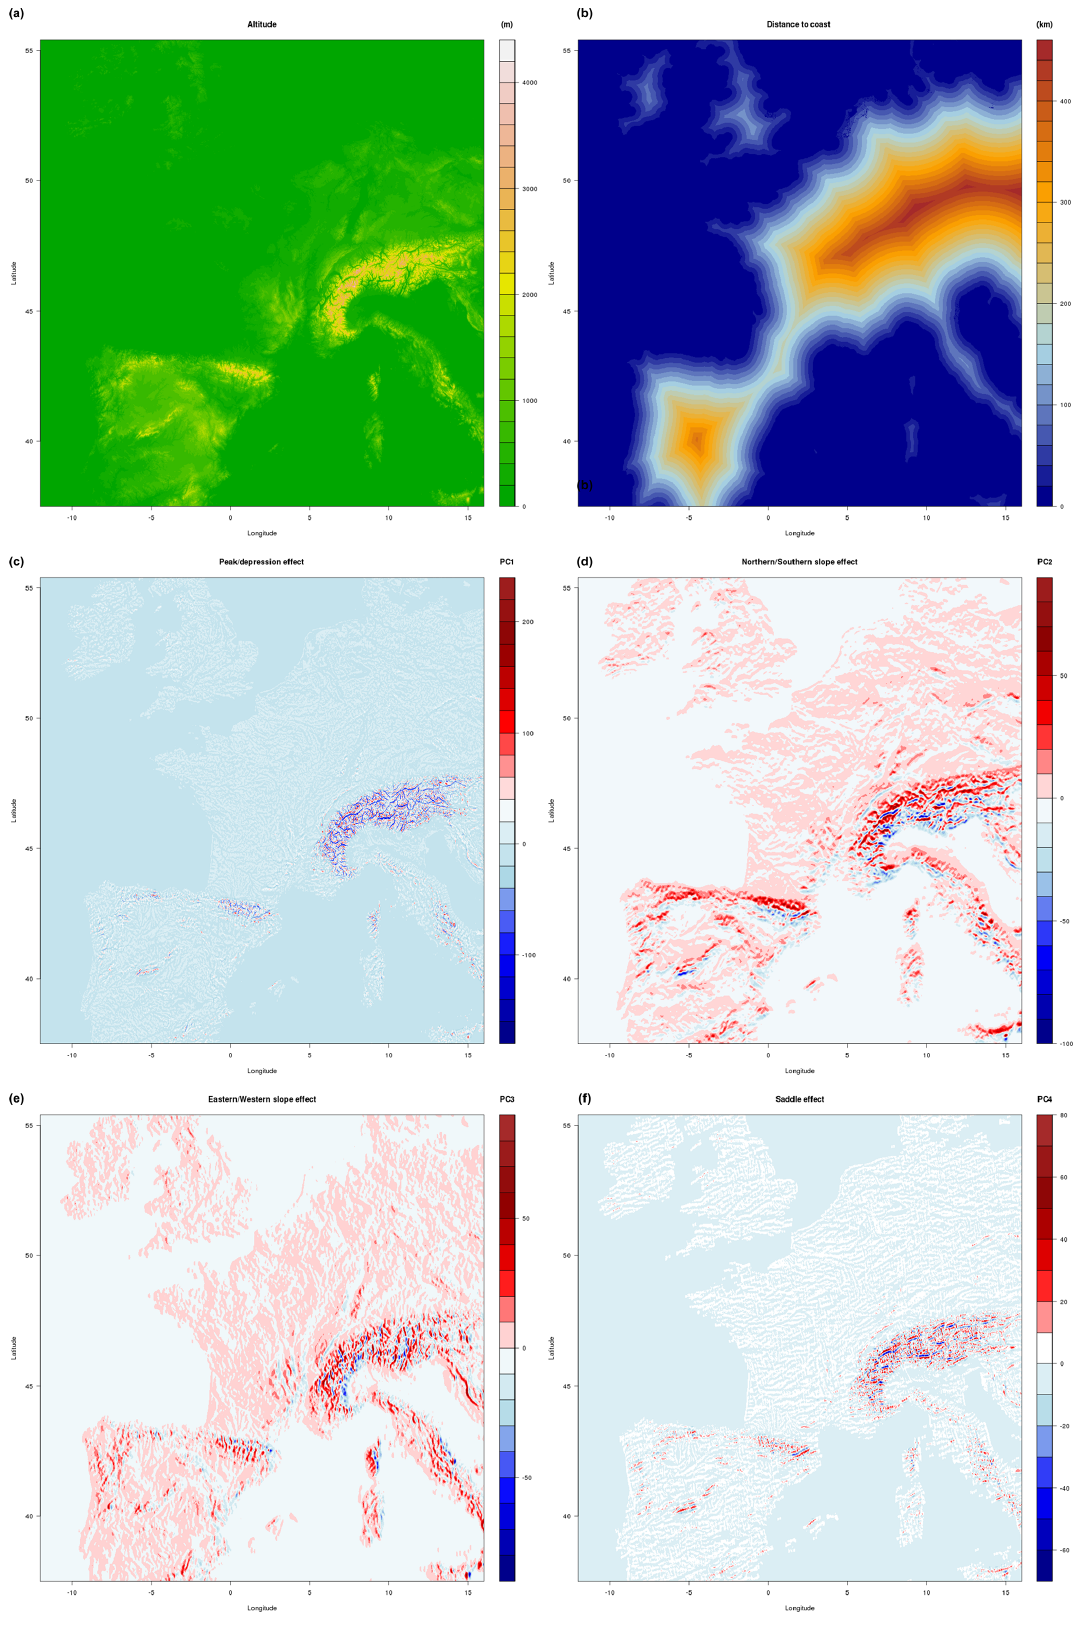
Figure 5. Altitude (a) , distance to sea (b) , and PC1 to PC4 (c–f)